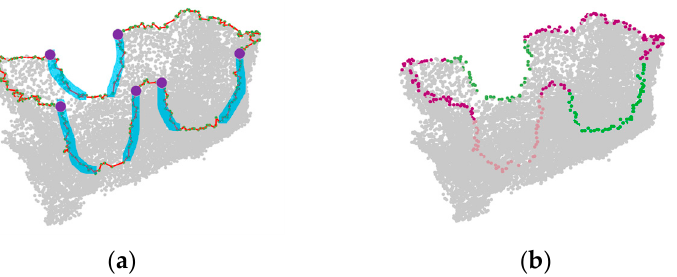
Figure 9. Example of hole boundary classification: ( a ) the segments with a continuous height increase or decrease (marked in blue) and the demarcation points (marked in purple); ( b ) hole boundary classification result; the boundary of the missing surface is marked in dark red; the boundaries of the mechanical claw holes are marked in green, light green and pink.